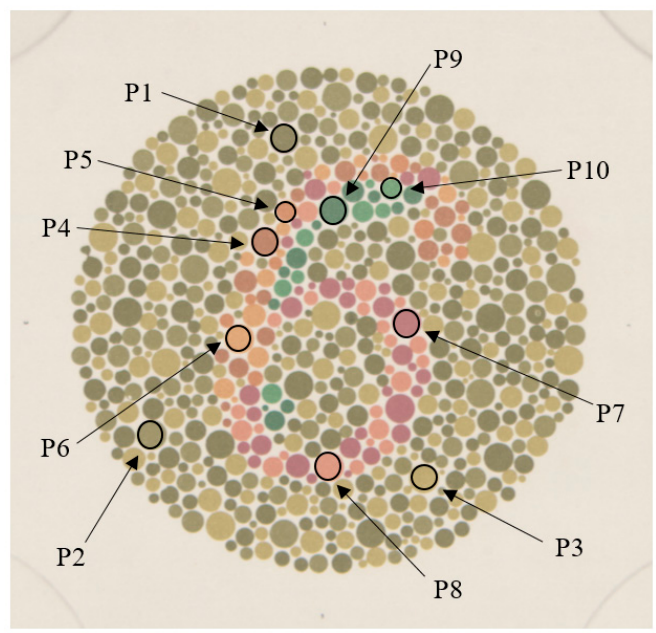
Figure 11. Screenshot Ishihara Plate number 3 selected to check the effectivity of color management. Table 5. Chromatic coordinates calculated from the hyperspectral image and measured from the virtual reality scene for 10 different color dots of Ishihara Test plate number 3. Calculated Color Measured Color Δ E Color Dot